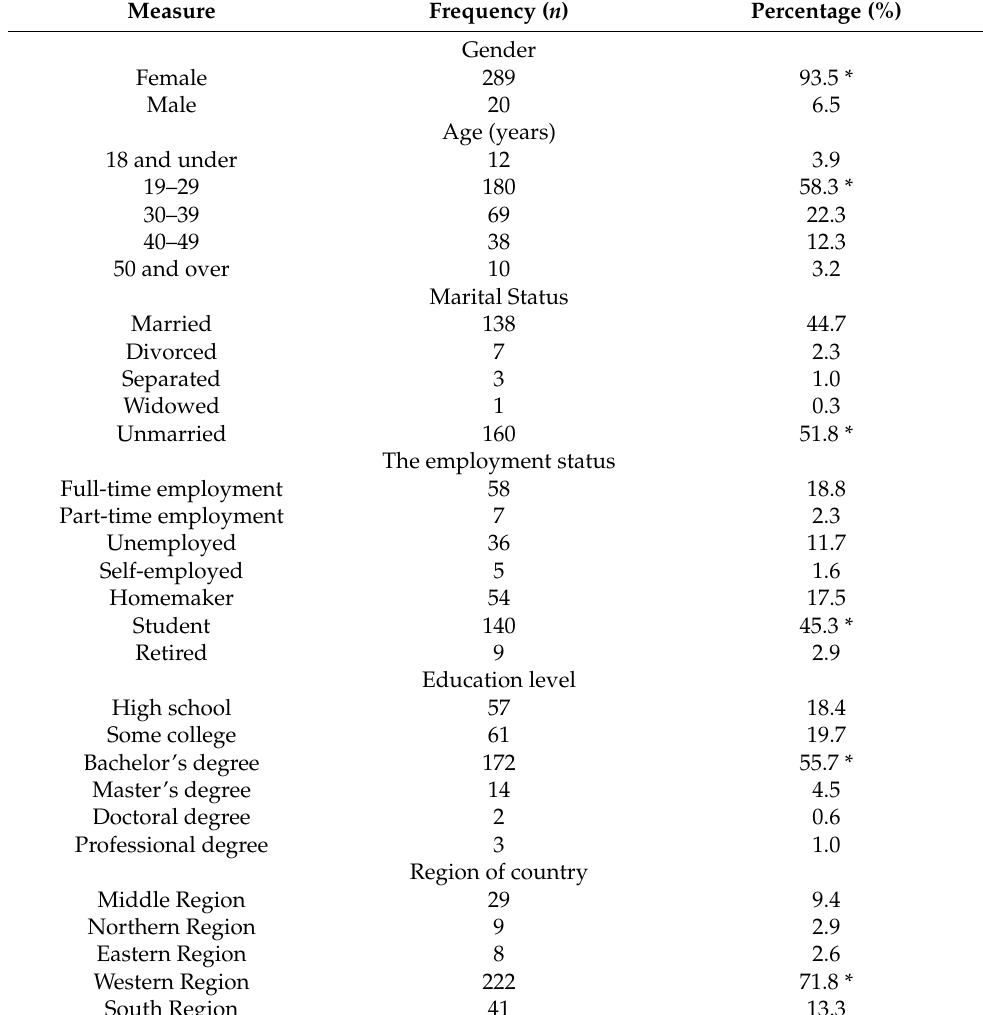
Table 1. Respondent demographic characteristics ( n =